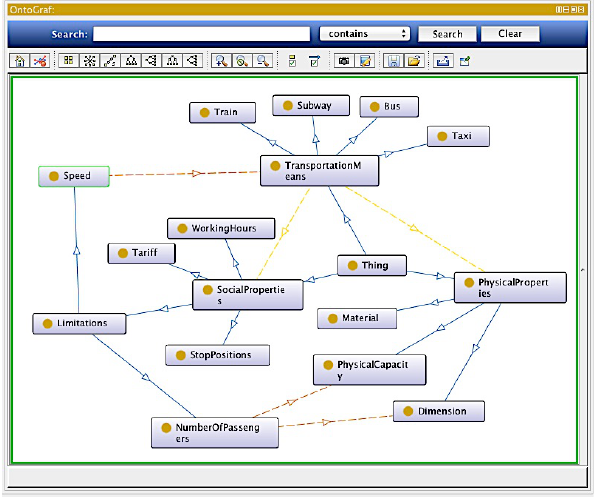
Figure 9. Transportation in different